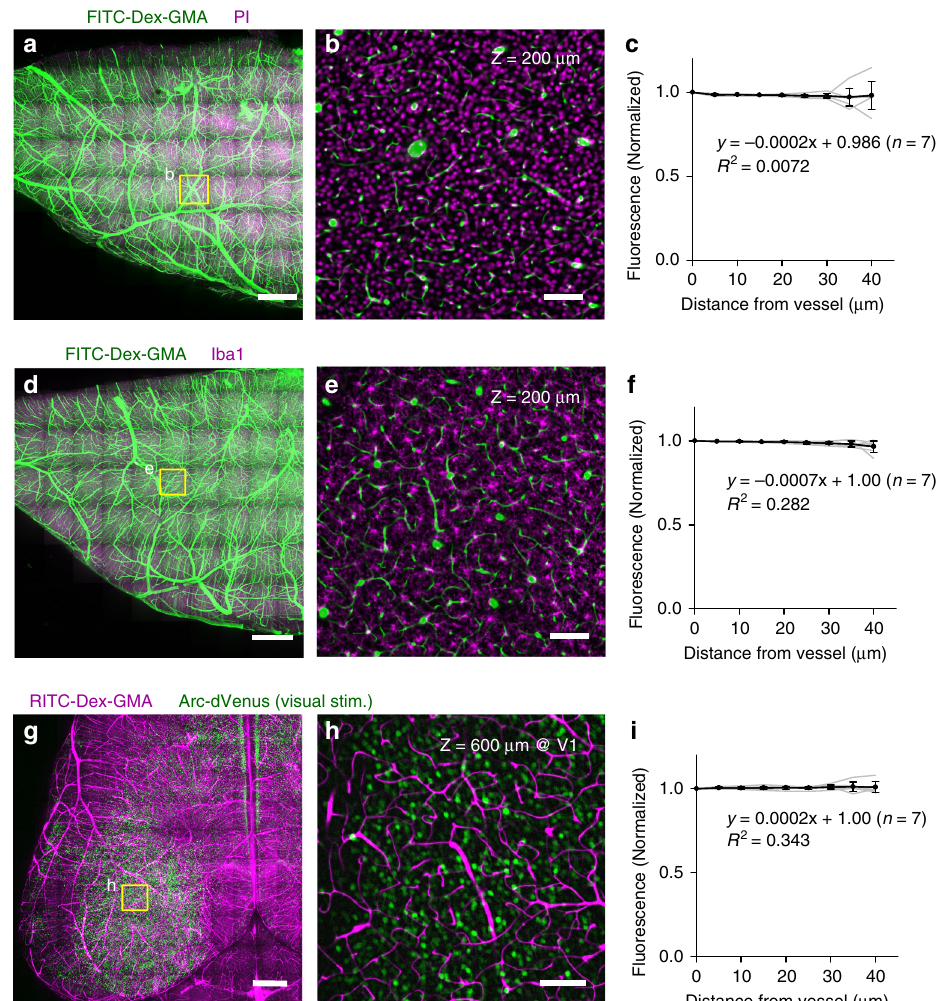
Fig. 4 SeeNet retains nucleic acids, proteins, and fl uorescence of endogenous probes. a Maximum projection of volumetric images of the cerebral hemisphere. The vasculature was cast using FITC – Dex – GMA (green). After delipidation with SDC, nucleic acids were labeled using PI (magenta). Then, the sample was RI-matched using Sca l eCUBIC-2. Scale bar = 1 mm. b An optical section of a boxed region in panel a at Z = 200 μ m. PI fl uorescence was uniformly retained across the section. Scale bar = 100 μ m. c The normalized median intensities of PI fl uorescence were plotted as a function of the distance from the nearest vessel. The intensities were almost unchanged depending on the distance. n = 7 hemispheres from seven mice. d – f The same as panels a – c showing the immunohistochemical signal of anti-Iba-1 (magenta). g – i The same as panels a – c showing RITC – Dex – GMA (magenta) and Arc-dVenus (green). Error bars represent standard deviations. Source data are provided as a Source Data fi